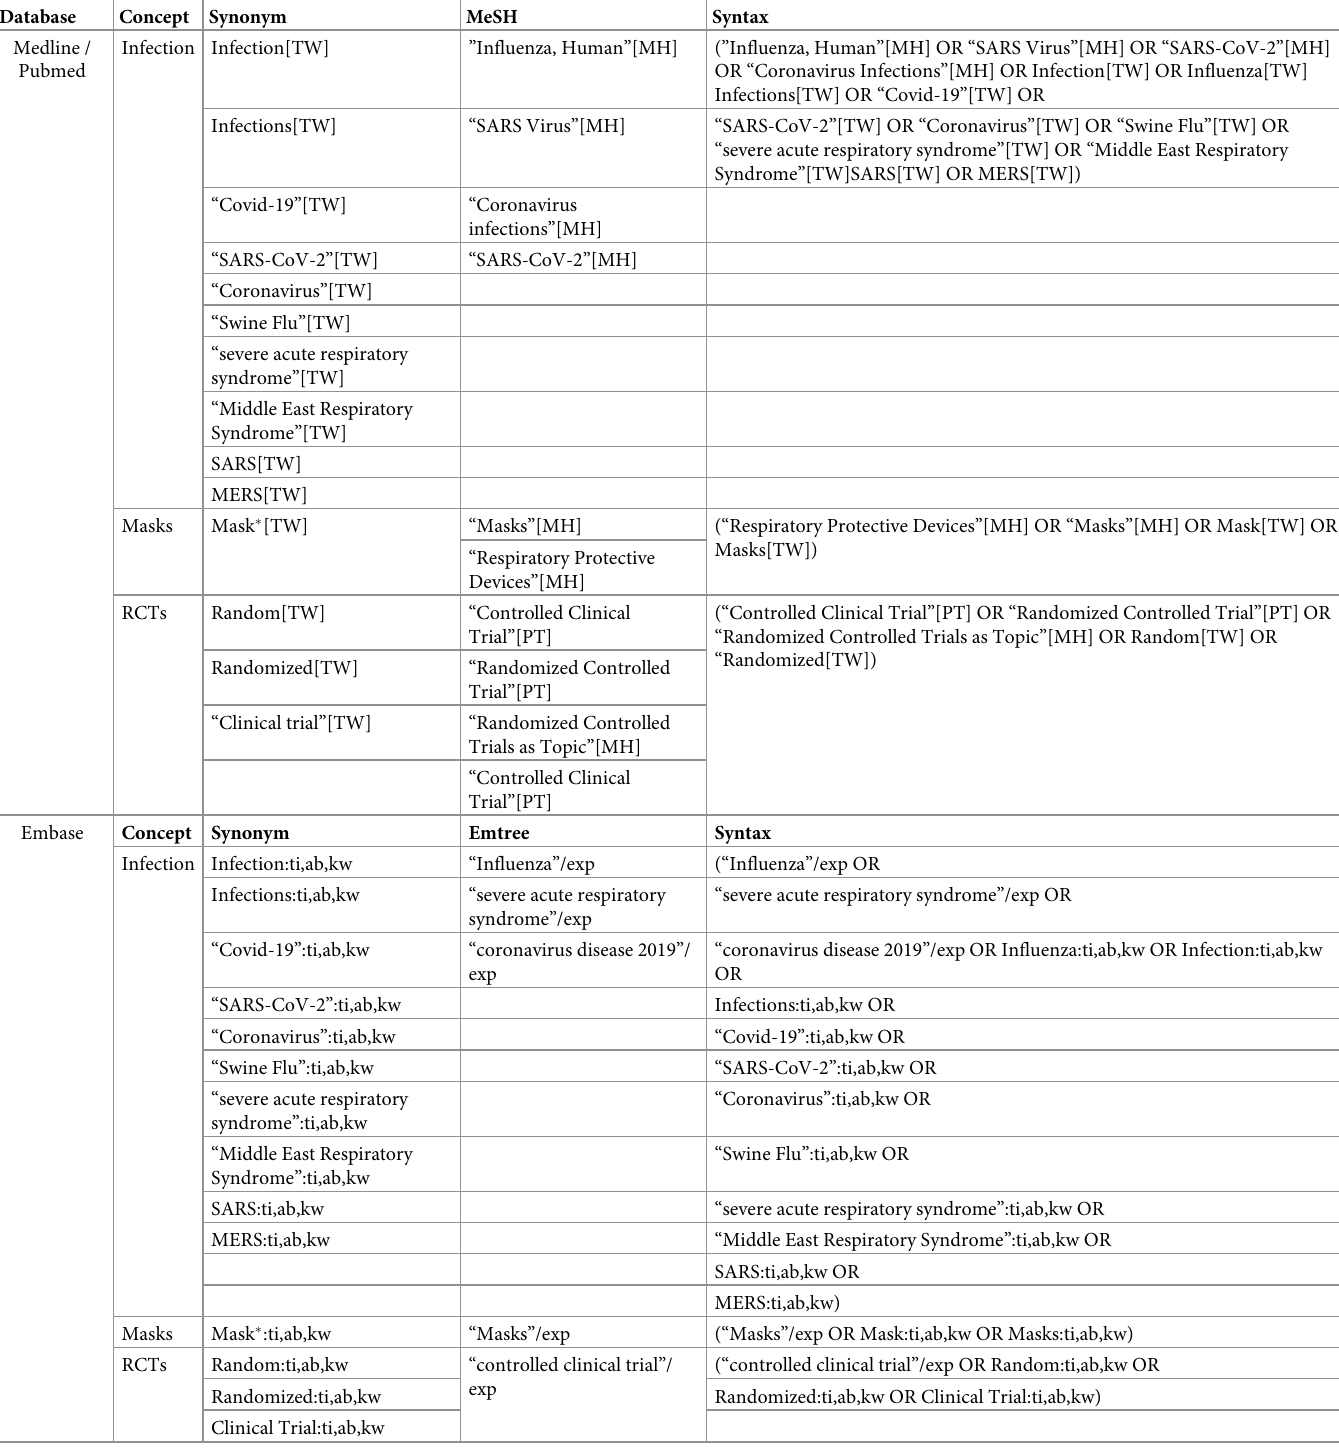
Table 1. Search strategy in each database. We list the concept, synonym, and syntax for each database. In addition, we provide Emtree and MeSH terms when applicable.